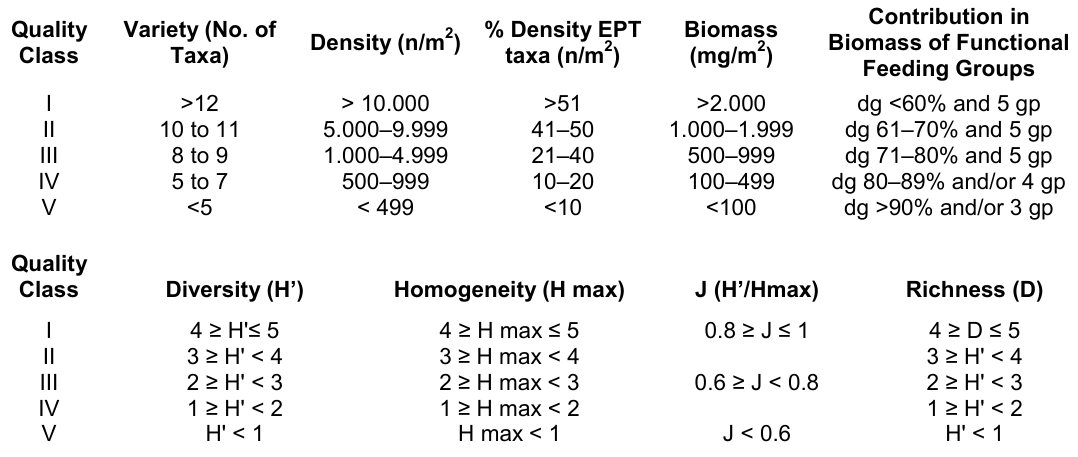
Method for Translating the Quantity Data for Macrobenthos into Functional Evaluations: